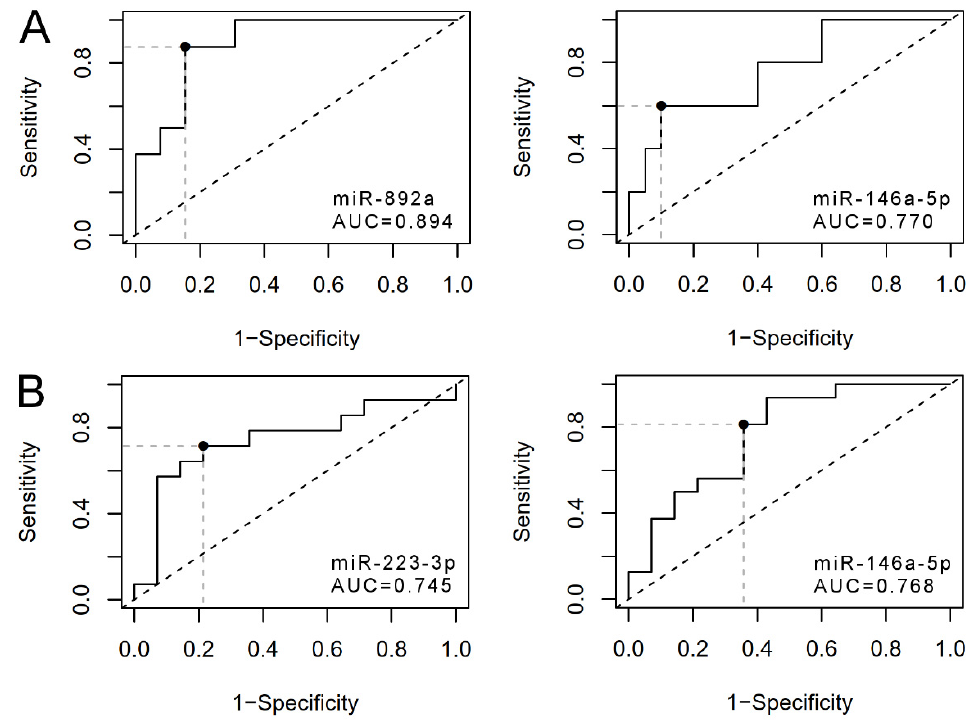
Figure 6. ROC curves. Receiver operator characteristic (ROC) curve analysis using qPCR data of the key differentially expressed miRNAs: ( A ) miR-892a and miR-146a-5p for separating Gleason score ≥ 8 (Group A) from the Gleason score 7 (B and C combined), as well as ( B ) miR-223-3p and miR-146a-5p for separating progressors (Groups I and II combined) from non-progressors (Group III). Area under the curve (AUC). Table 2. Fold changes of differentially expressed miRNAs between prostate cancer groups in qPCR. Table includes only the most significant miRNAs with statistically significant changes in both miR- NAseq analysis and in qPCR validation. Results marked in bold had a higher statistical significance (FDR p < 0.05 to <0.0001) than the rest ( p < 0.05 to <0.0001). Fold change (FC), quantitative polymerase chain reaction (qPCR).